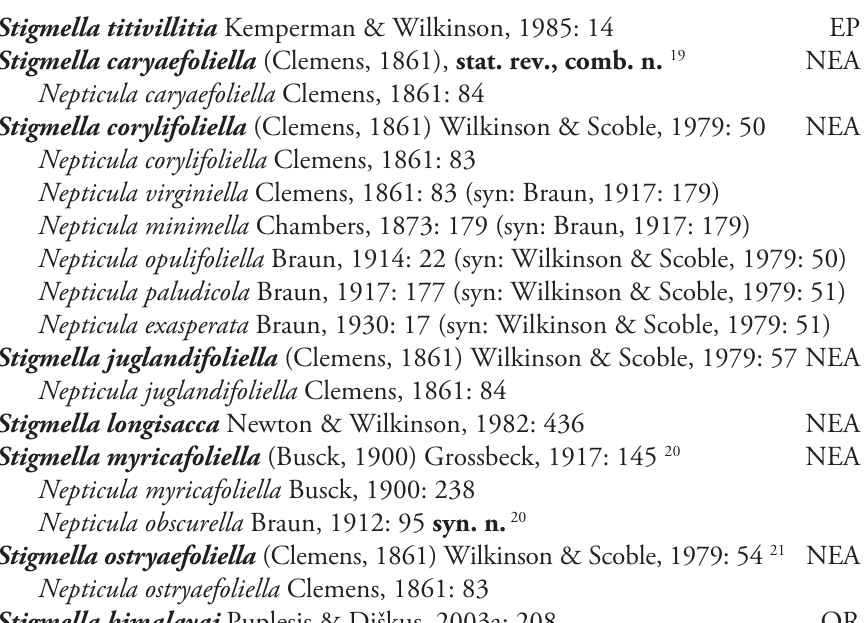
Stigmella allophylica Scoble, 1978b: 97 AFR Stigmella allophylivora Gustafsson, 1985: 167 AFR Stigmella androflavus Scoble, 1978b: 104 AFR Stigmella generalis Scoble, 1978b: 102 AFR Stigmella geranica Scoble, 1978b: 96 AFR Stigmella hortorum Scoble, 1978b: 99 AFR Stigmella pelanodes (Meyrick, 1920b), comb. n. 22 AFR Nepticula pelanodes Meyrick, 1920b: 116 Stigmella potgieteri Scoble, 1978b: 99 AFR Stigmella satarensis Scoble, 1978b: 97 AFR Stigmella tragilis Scoble, 1978b: 98 AFR Stigmella tropicatella Legrand, 1965: 27 23 AFR Stigmella triumfettica Scoble, 1978b: 107 AFR Stigmella divina group (Puplesis & Diškus, 2003a: 212) Stigmella divina Puplesis, Diškus & van Nieukerken, 1997: 55 WP Stigmella maculifera Puplesis & Diškus, 2003a: 212 WP Stigmella skulei Puplesis & Diškus, 2003a: 213